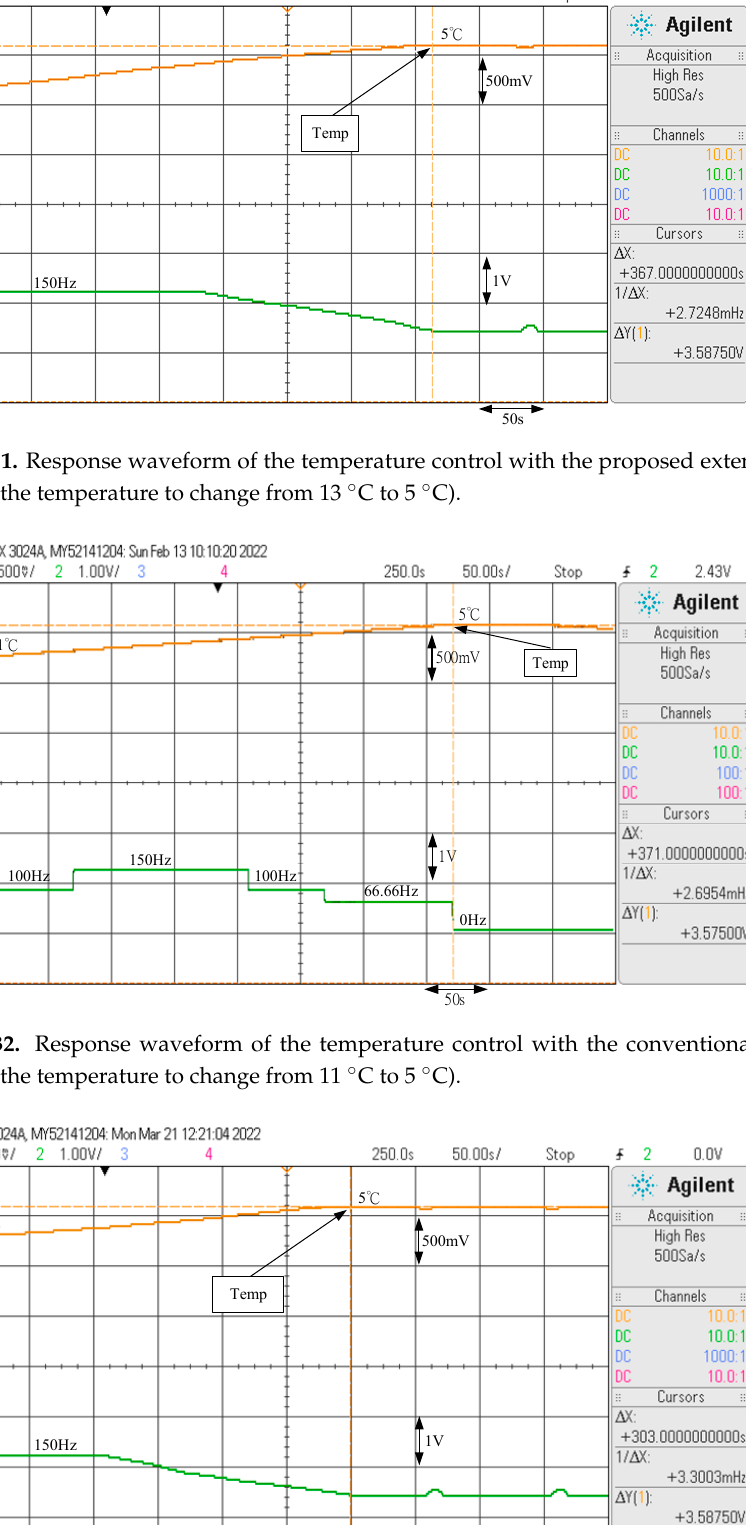
Figure 33. Response waveform of the temperature control with the proposed extension controller (control the temperature to change from 11 °C to 5 °C).